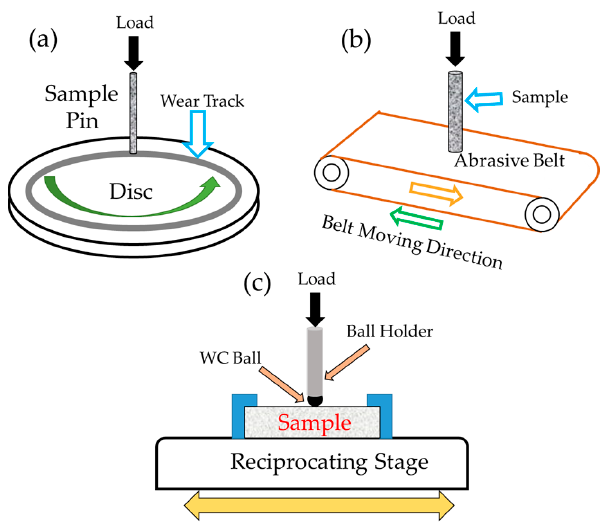
Figure 1. Illustration of ( a ) pin-on-disc test setup; ( b ) pin-on-belt setup; and ( c ) sliding reciprocating wear stage.